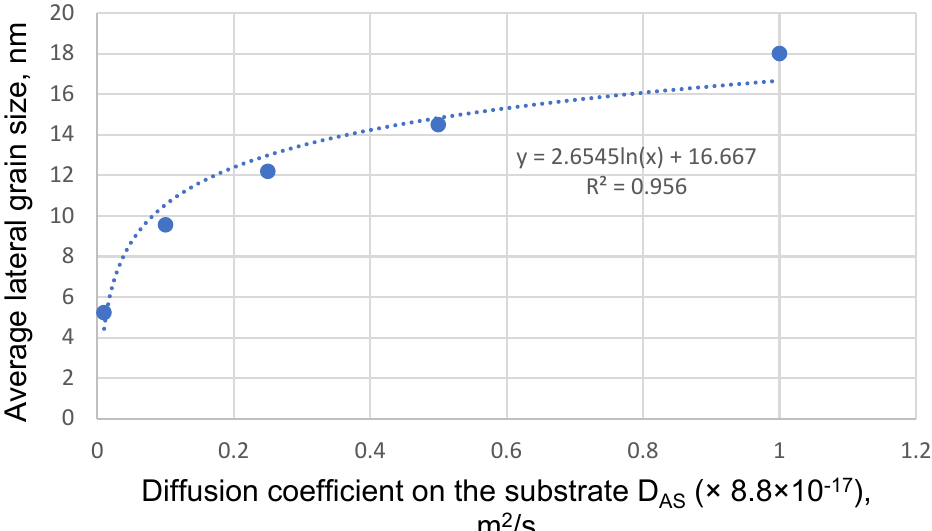
Figure 3. Plot of average lateral grain size near the substrate versus diffusion coefficient of component A on the substrate, D AS .